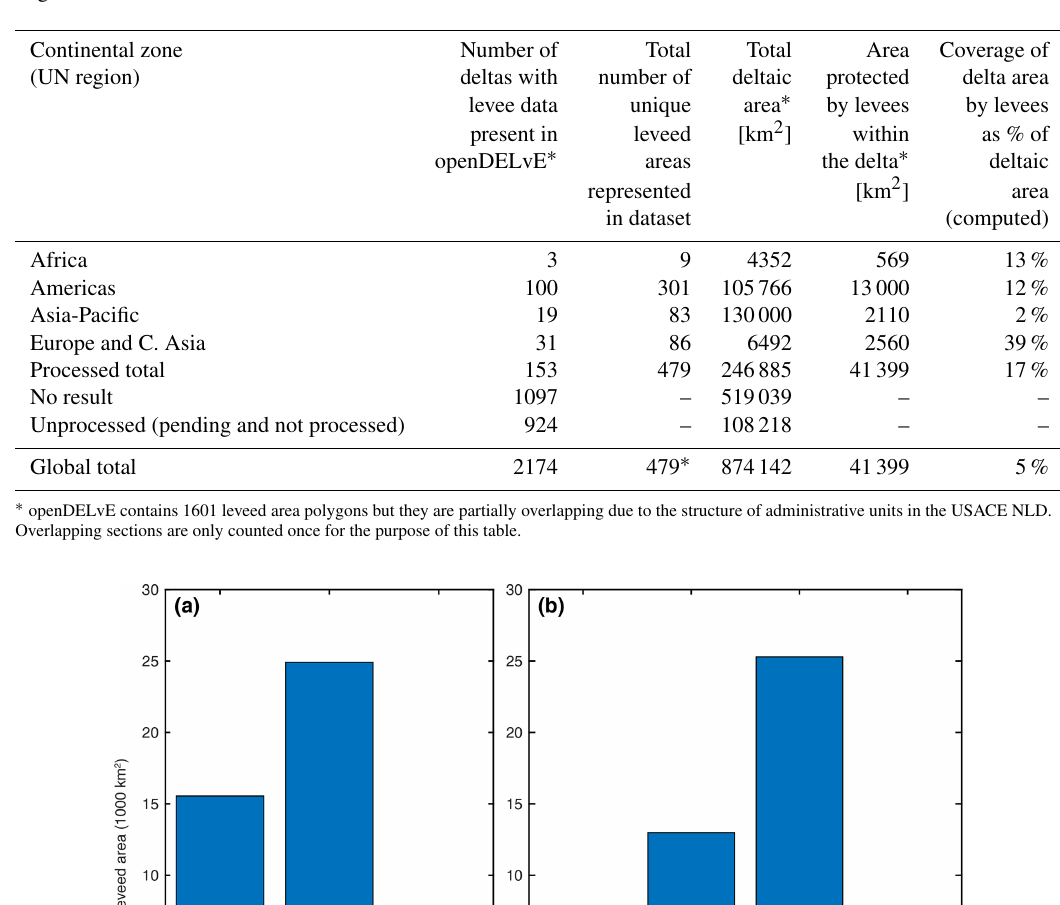
Table 5. Summary of processed features and deltaic areas at openDELvE (current release) per geographic region and area totalled, rounded to nearest integer.